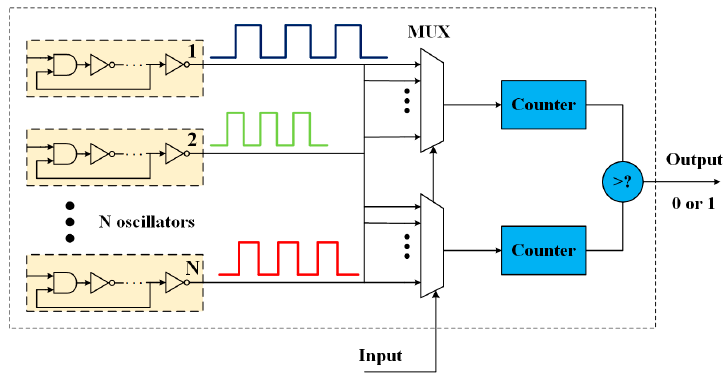
Figure 1. 1-out-of-N ring oscillator-based physical unclonable function (RO PUF) architecture [10].